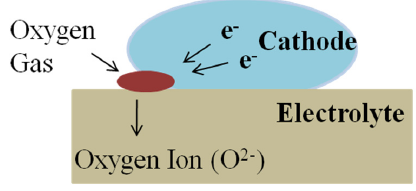
Figure 2. Schematic of triple phase boundary.